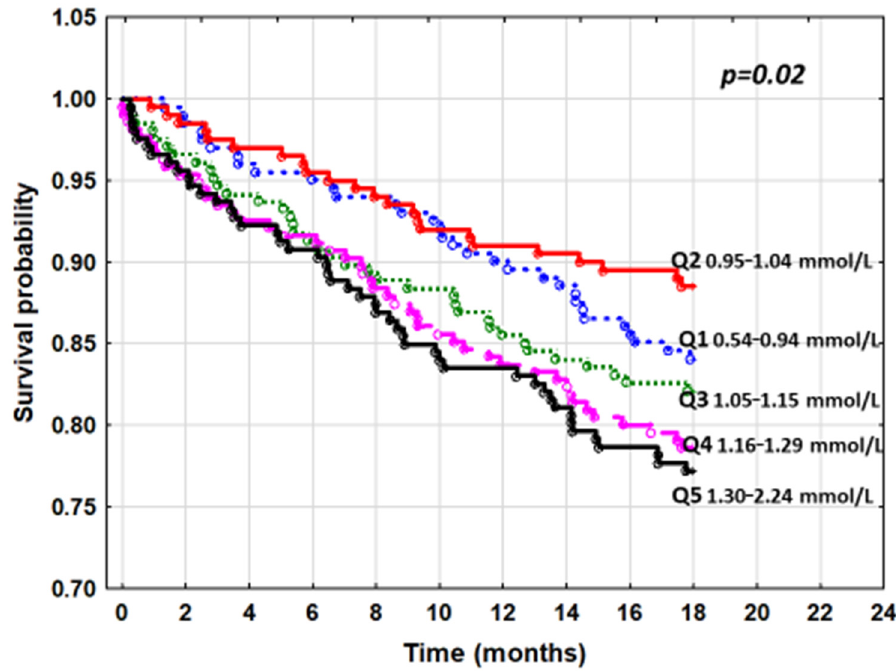
Figure 1. The cumulative survival curves by Kaplan–Meier for quintiles of serum phosphorus and all-cause mortality.